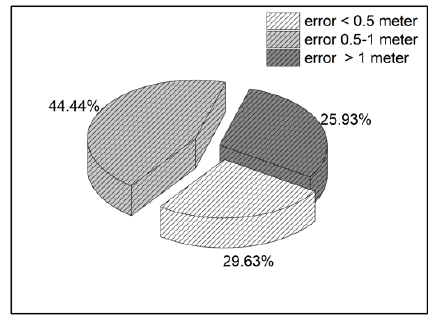
Figure 11. Accuracy of positioning results using MLP + RBF.